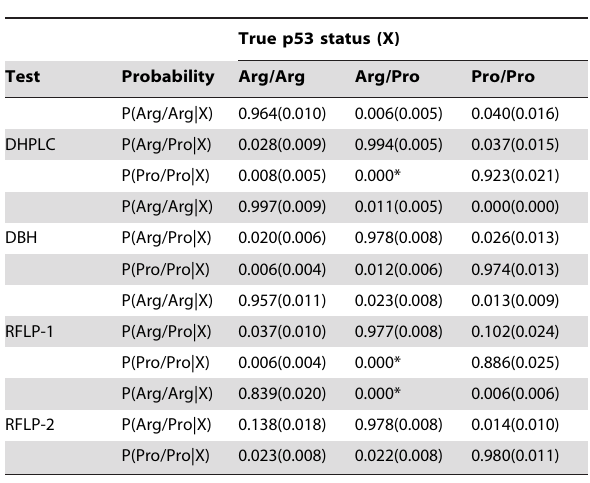
Table 3. Classification probabilities (standard errors) for p53 genotype by four laboratory tests, according to true p53 status: results from Model 1.